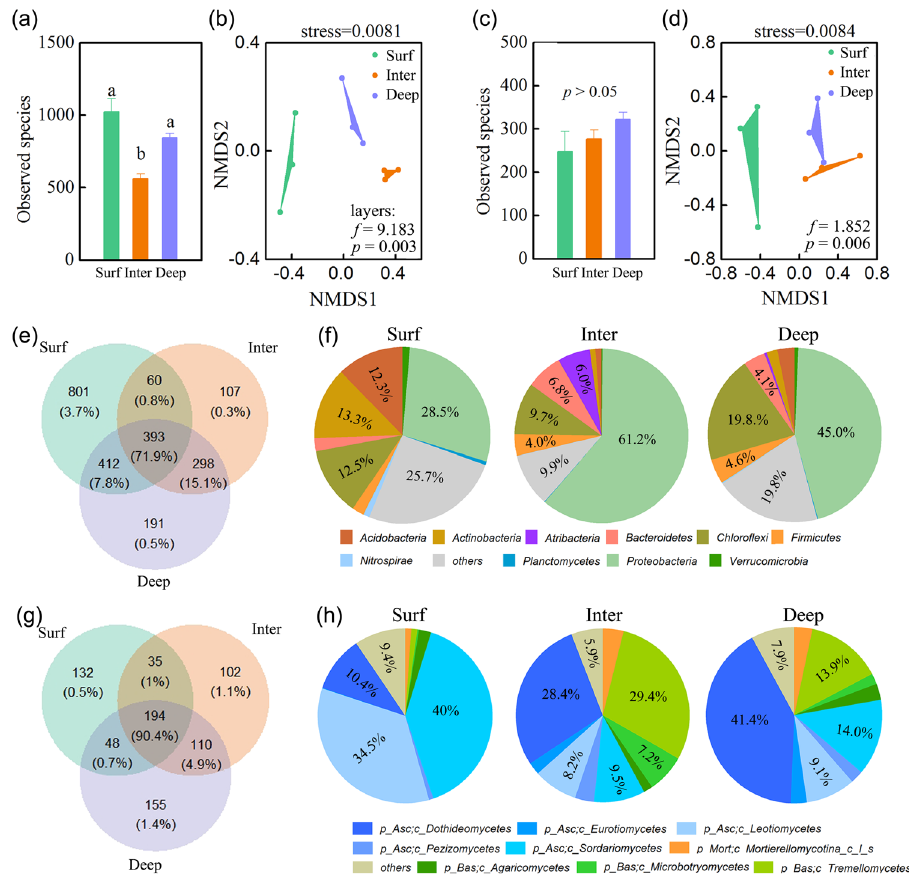
Fig. 3 Comparison of bacterial and fungal diversity and composition in the three water table-dependent soil layers. a , c Alpha diversity of bacteria and fungi, de fi ned in terms of the numbers of species observed. b , d Nonmetric multidimensional scaling ordinations of community dissimilarities among three layers, based on Bray-Curtis dissimilarity ( f and p represent differences of community composition among layers). e , g Overlap and differences in unweighted numbers of bacterial and fungal OTUs. f , h Relative abundances of bacterial phyla and fungal classes showing >0.5% abundance. Surf surface, Inter